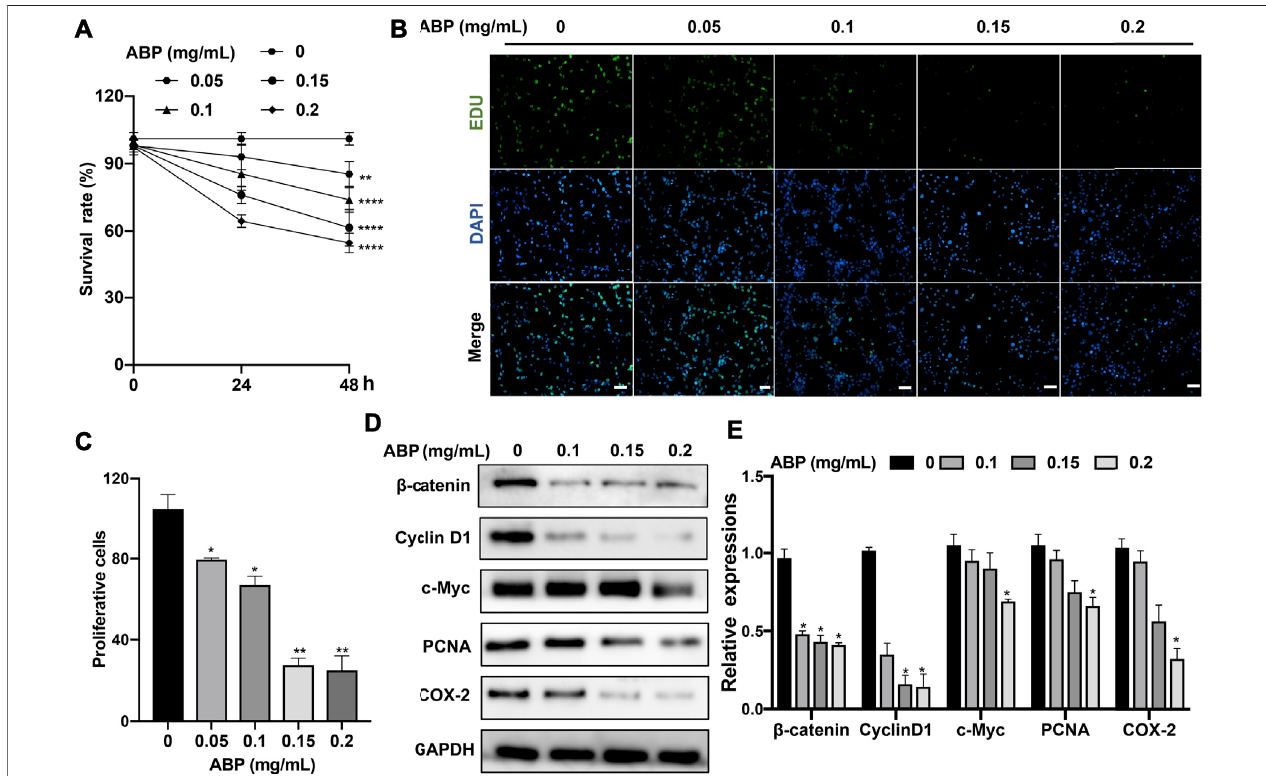
FIGURE1| ABPtreatmentsuppresses theproliferationofCRC cells. (A) CCK-8assayexaminingthe proliferation-suppressing effect ofABPonCT26 cells. (B – C) EdUuptakeassayexaminingtheproliferation-suppressingeffectofABPonCT26cells.Scalebar (cid:2) 50 μ m( × 200magni fi cation). (D – E) Westernblotexaminingtheeffect of ABP on the protein levels of β -catenin, Cyclin D1, c-Myc, PCNA, COX-2, and GAPDH in CT26 cells. Compared with the untreated group, * p < 0.05, ** p < 0.01.